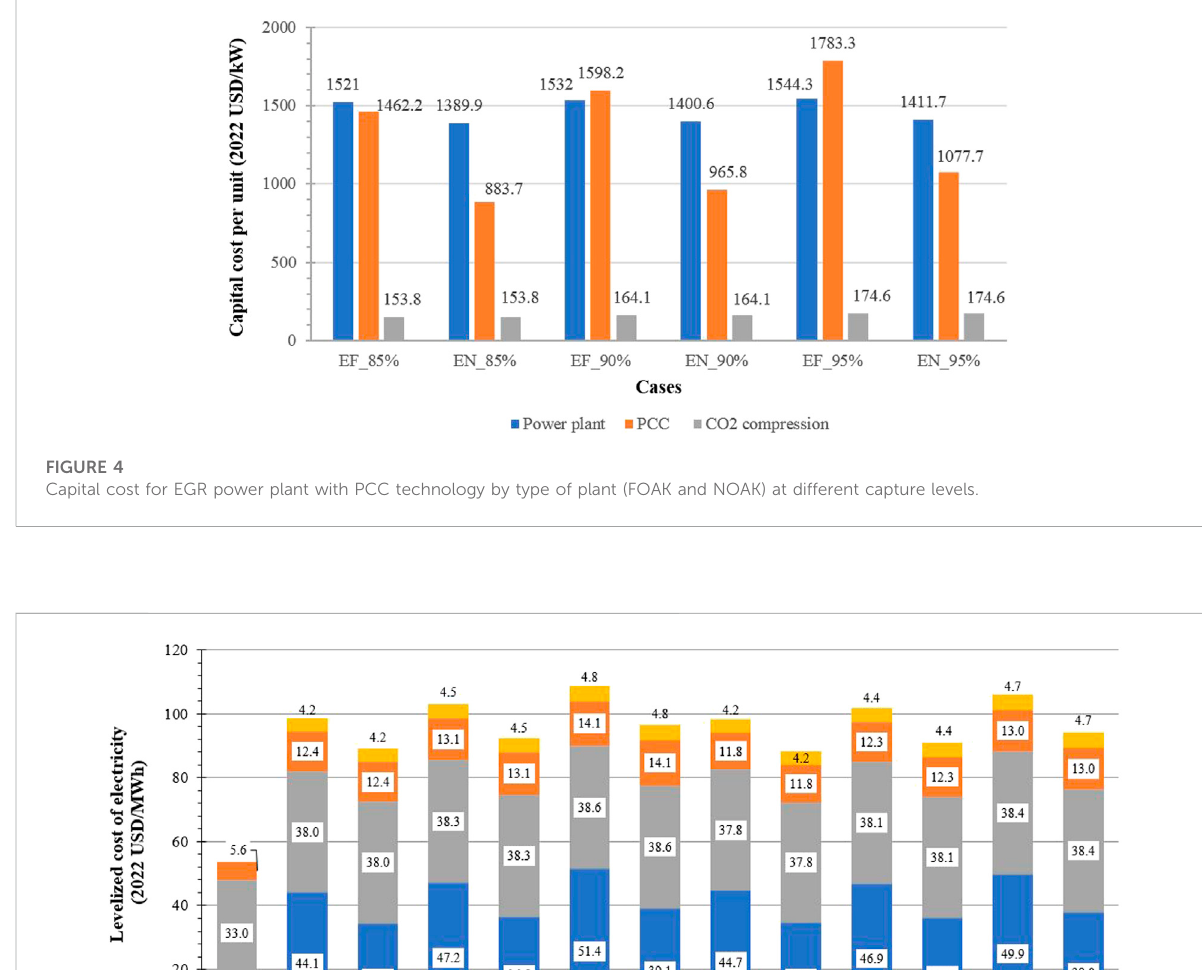
Frontiers in Energy